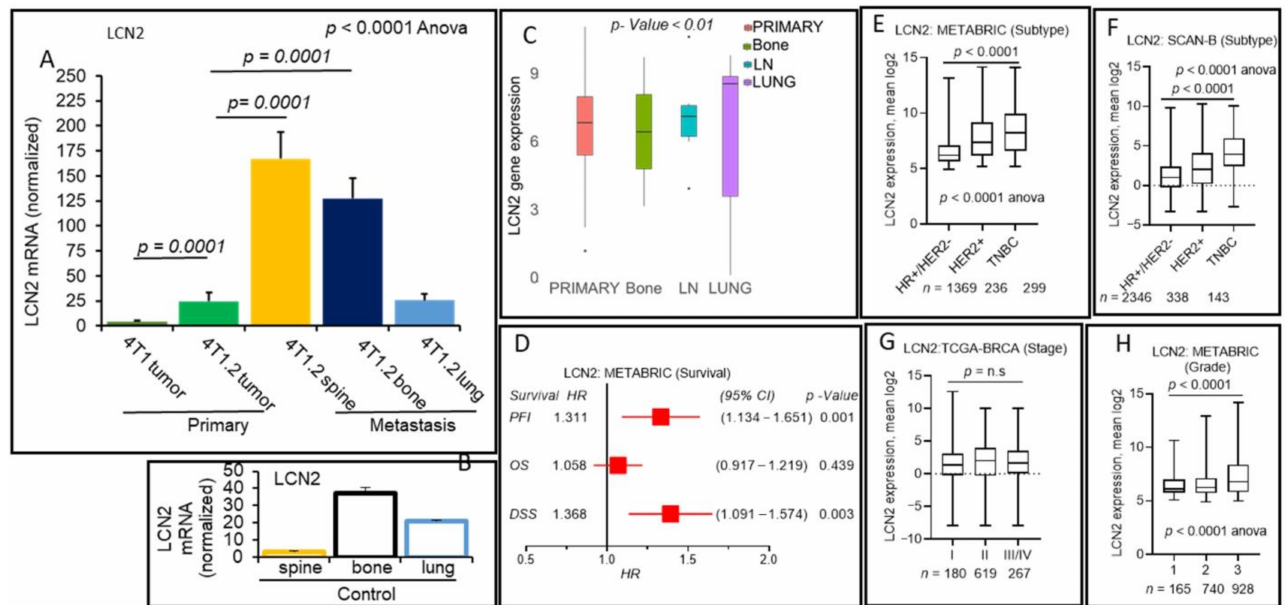
Figure 4. LCN2 is upregulated at the metastatic sites (spine and bone) vs. primary tumor and an independent prognostic factor for breast cancer patients. ( A , B ) qPCR analyses were performed to validate RNA-seq data between 4T1 vs. 4T1.2 cell lines using primary tumors. LCN2 mRNA normalized levels were determined in 4T1.2 primary tumors vs. metastatic lesions in the spine, bone, and lung ( A ). LCN2 mRNA normalized levels were also determined in the control tissues isolated from the spine, bone, and lung ( B ). mRNA levels were normalized with GAPDH, as described before. Data are mean ± SEM, one-way ANOVA p < 0.0001, Tukey’s post hoc test, p < 0.05, n = 3. ( C ) Boxplots show a high LCN2 expression score of primary tumors vs. metastasis to bone, LN, or the lung. Boxplots analyses, the Kruskal–Wallis test (non-parametric method), p < 0.05, suggested an altered expression of LCN2. ( D ) Patients with a high LCN2 expression score and association of survival of breast cancer patients for the METABRIC cohort. LCN2 high vs. low expression scores survival rates (PFI, OS, or DSS) for the patients of METABRIC cohort and HR, CI, and p values are shown ( D ). Boxplots of the LCN2 high expression score by immunohistochemistry (IHC) determined subtype in the METABRIC ( E ) and SCAN-B cohorts ( F ). Similar data were obtained from the TCGA-BRCA cohort. All boxplots are of Tukey type, and boxes depict medians and inter-quartile ranges. One-way ANOVA was used to calculate the p -value. Boxplots of high expression of LCN2 score of tumors of different American Joint Committee on Cancer (AJCC) stages ( G ) and Nottingham pathological grades ( H ) are shown for the METABRIC cohort. Similar data obtained from the TCGA-BRCA cohort. One-way ANOVA and Tukey’s tests were used to calculate p